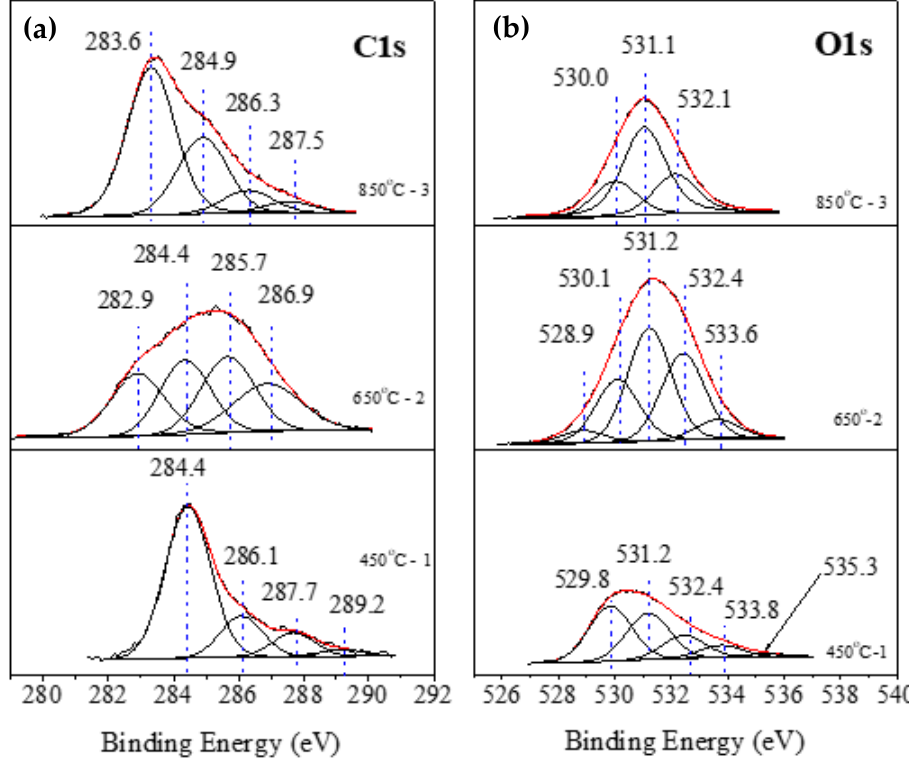
Figure 8. ( a , b ). XPS high-resolution carbon 1s and oxygen 1s core-level spectra.